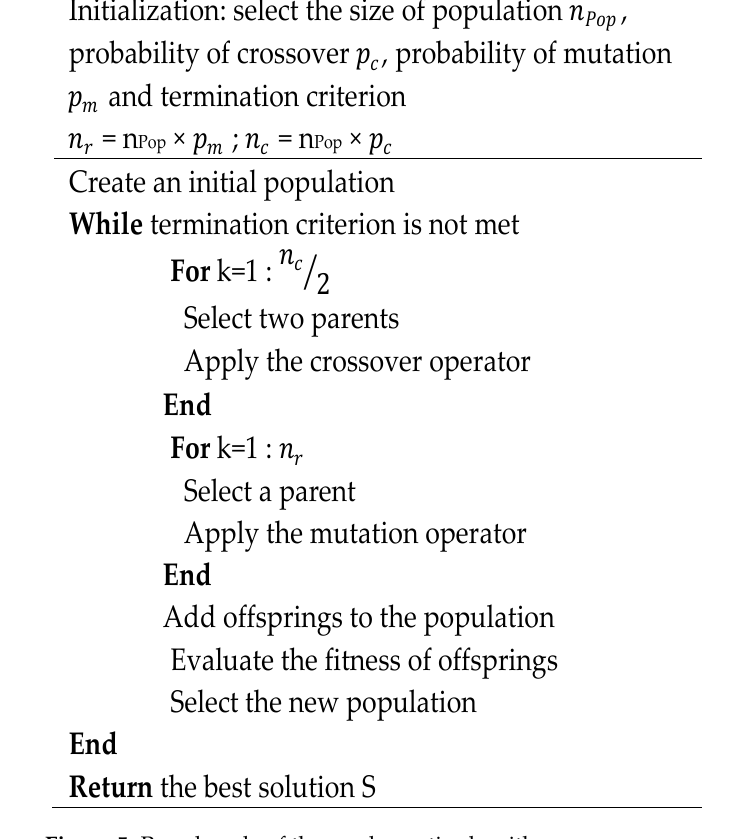
Figure 5. Pseudocode of the used genetic algorithm.